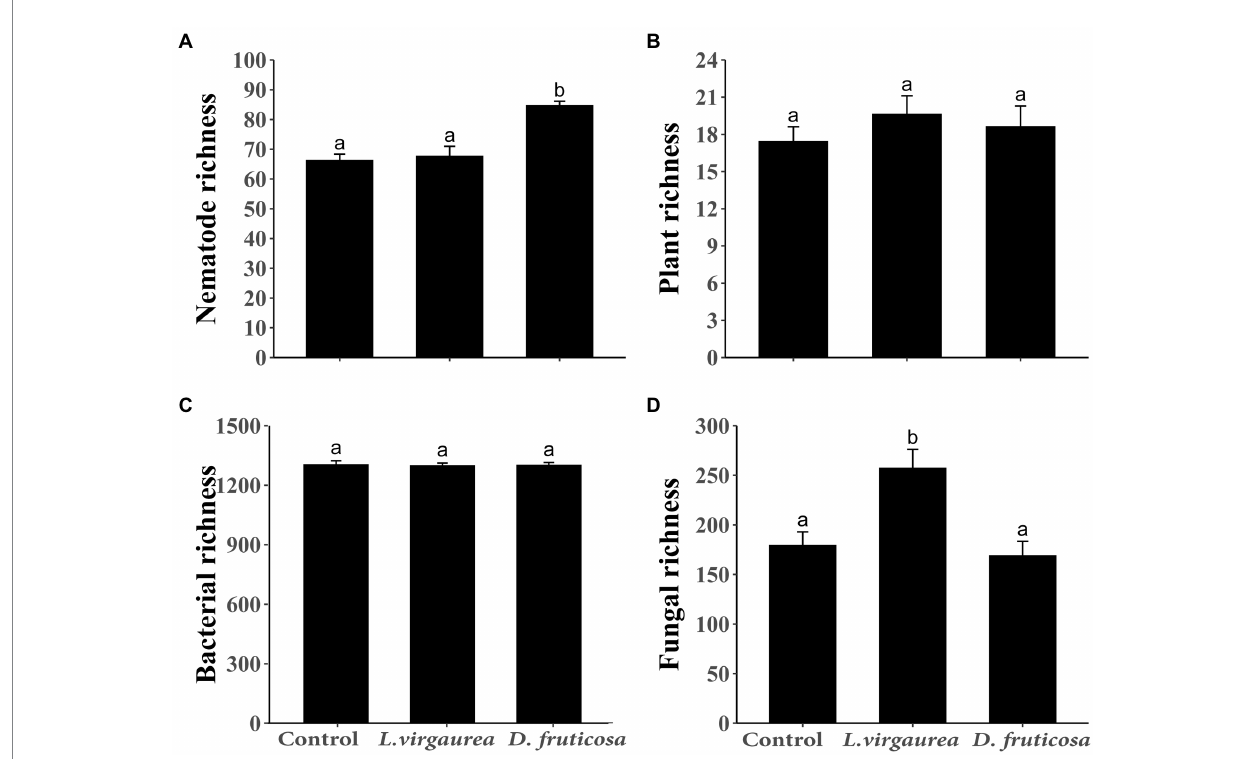
FIGURE 1 Mean (± SE) (A) nematode OTU richness, (B) understory plant richness, (C) bacterial OTU richness, and (D) fungi OTU richness across the treatments. Different letters indicate significant differences among treatments ( p < 0.05) as determined by Tukey HSD